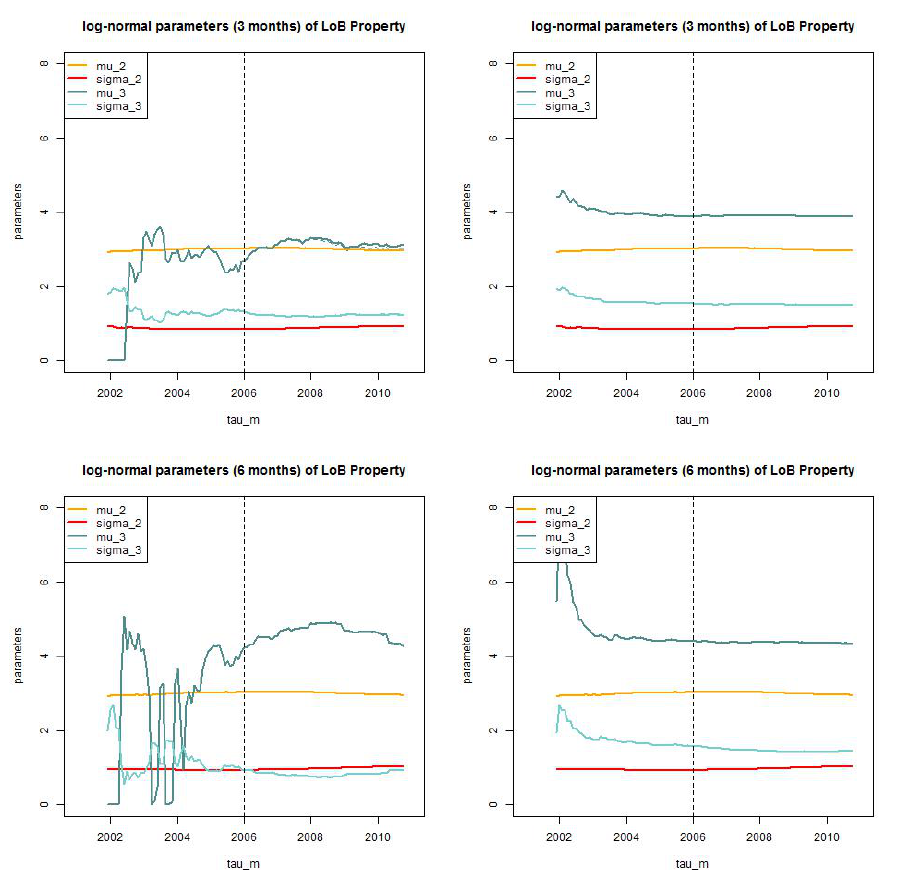
Figure 12. LoB Property: parameter estimates of ( µ 2 , σ 2 , µ 3 , σ 3 ) for the dynamic model α > 0 with γ = 1/4 for τ m ∈ { 31/12/2010, . . . ,31/10/2010 } (top, lhs) u ( 2 ) = 3 months truncated/truncated and (top, rhs) and truncated/shifted; and (bottom, lhs) u ( 2 ) = 6 months truncated/truncated and (bottom, rhs) and